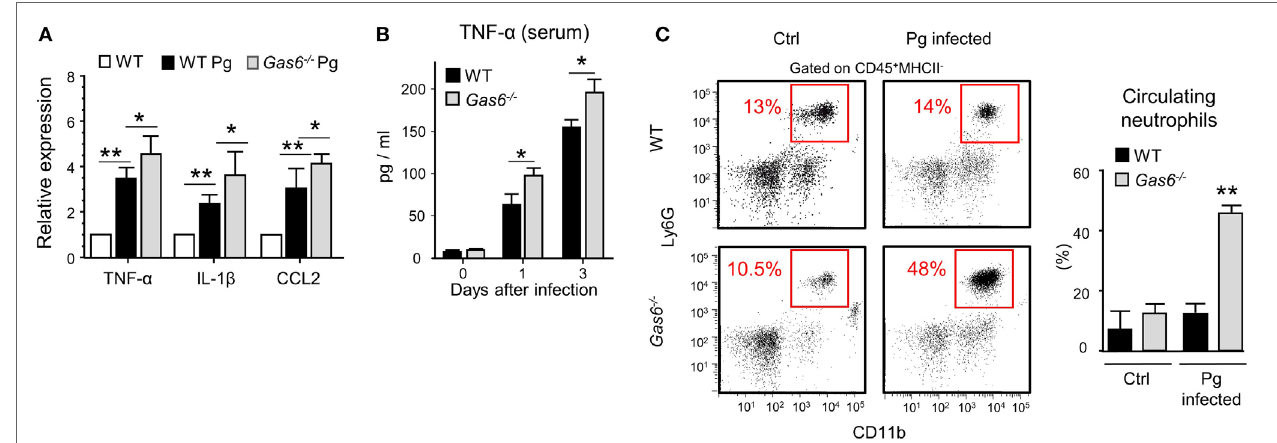
FigUre 4 | Elevated expression of pro-inflammatory cytokines in Gas6 − / − mice following infection with Pg. (a) Expression levels of TNF- α , IL-1 β , and CCL2 in the gingiva 24 h after a single infection with Pg. Data are presented as relative mRNA expression analyzed by RT- q PCR and represent the mean of five mice ± SEM. (B) Serum levels of TNF- α , on days 0, 1, and 3 days post-infection, measured by ELISA. Graphs represent the mean of five mice ± SEM. Representative data of one out of three independent experiments is shown. (c) Peripheral blood samples were collected from naive and infected mice 24 h after infection for flow cytometry analysis. Representative FCAS plots and bar graphs demonstrate the percentages of neutrophils in the blood. Bar graphs represent the mean of five mice per group ± SEM. Representative data of one out of three independent experiments is